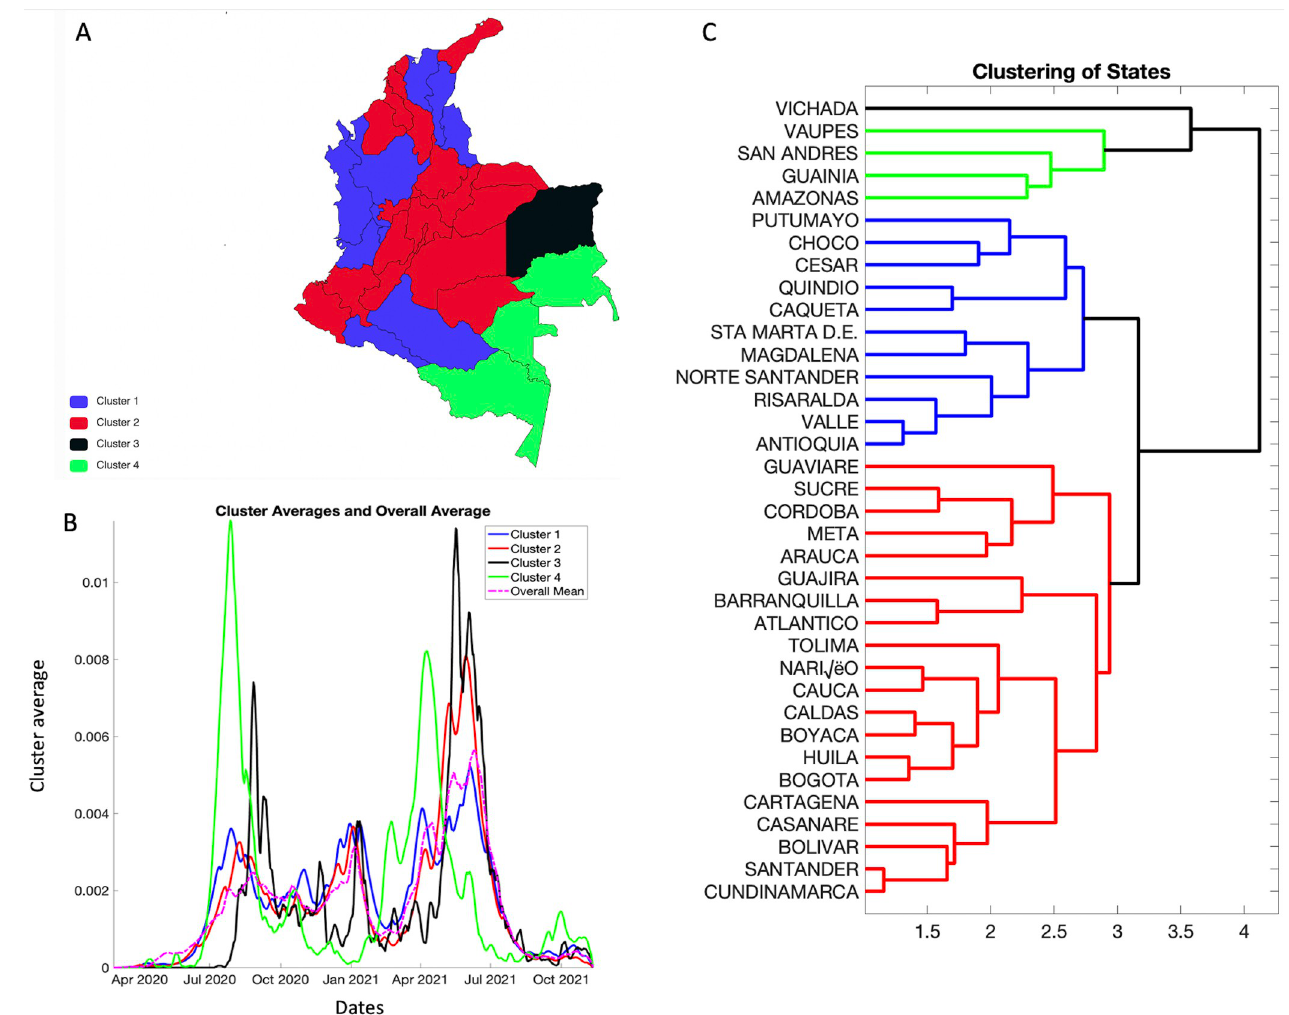
Fig 11. Panel A. Clustering of states according to the shapes of their rate curves. Cluster 1 is shown in blue, cluster 2 is shown in red, the smallest cluster, cluster 3 is shown in black whereas cluster 4 is shown in green. One can see that states with similar shapes of rates curves are geographically close to each other. The panel shows the geographic distribution of the clusters created in PaintMaps.com, https://paintmaps.com/map-charts/51/Colombia-map-chart [81]. Panel B. Shows the average shape of the incidence rate curves in each cluster and the overall average. Panel C. Shows the dendrogram plot- a hierarchal clustering of states, which shows that there are four predominant clusters of